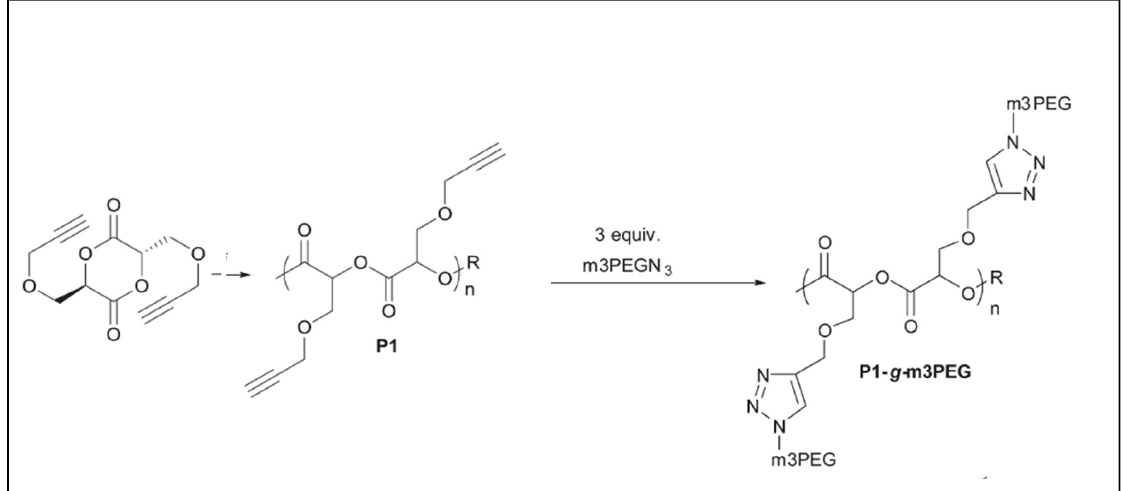
Figure 3. Reaction scheme for the synthesis of dipropargyloxymethyl PLA and the grafting of PEG via click a reaction (adapted from Zhang et al. [17], Copyright Royal Society of Chemistry, reproduced with permission).